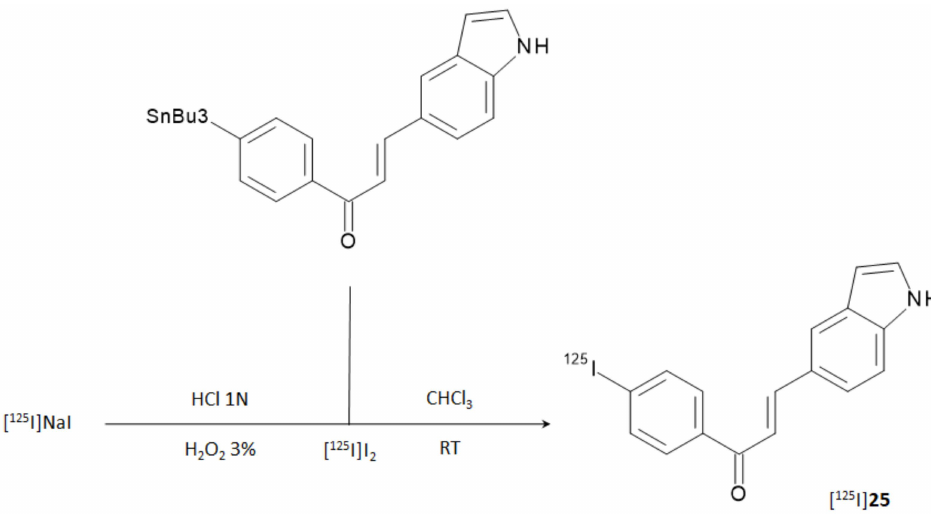
Figure 10. Reaction steps for the labeling of [ 125 I]iodophenyl-indole-chalcone ([ 125 I] 25